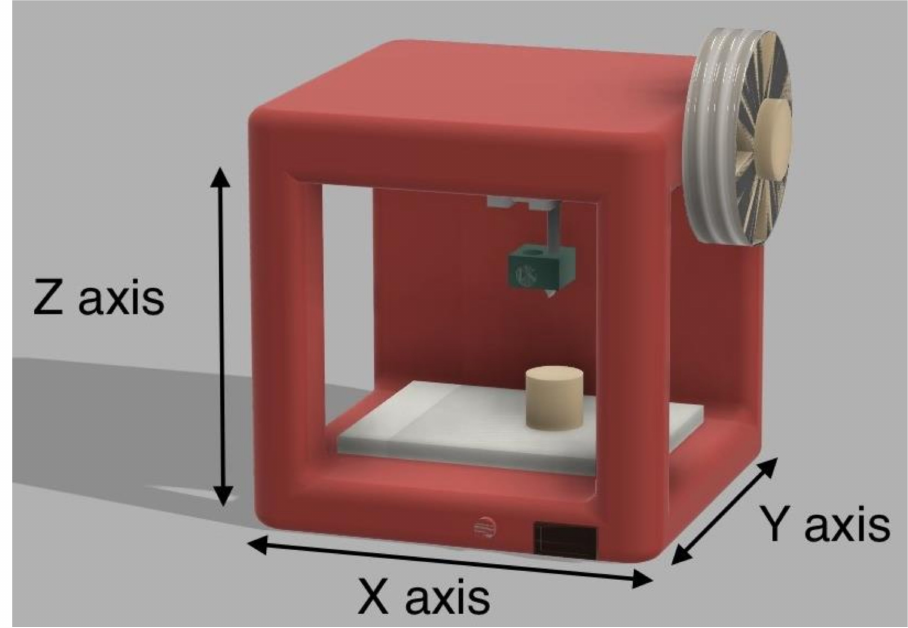
Figure 3. Three-dimensional (3D) printer using PLA filaments in the fused deposition modeling (FDM)